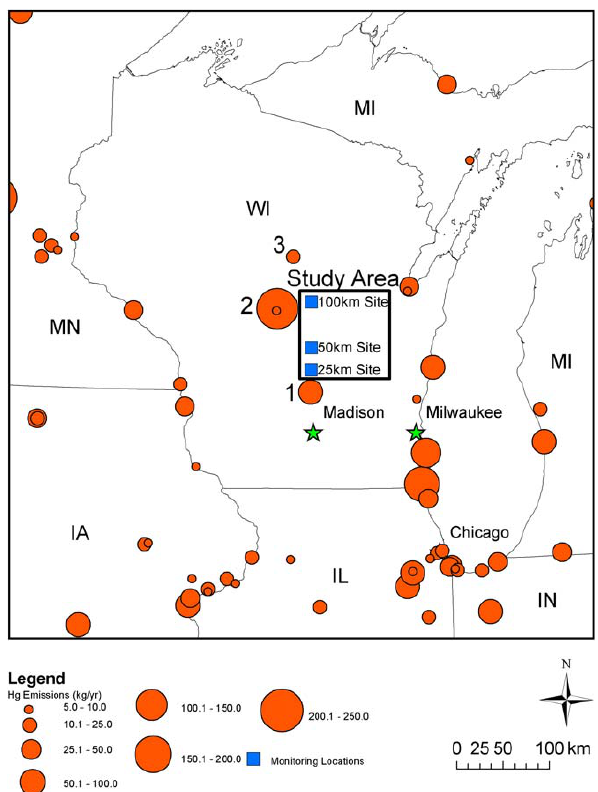
Fig. 1. Map of Wisconsin and adjoining States showing distribution of mercury emitters as of 2006, from EPA Toxics Release Inventory (EPA, 2008). Three emitters adjoin the study area: 1) 1114 MW coal-burning utility power station; 2) mercury-bed process chlor-alkali facility; and 3) 465 MW coal-burning utility power station. Mercury emitters contributing 5.0 kg/yr or less are not shown.